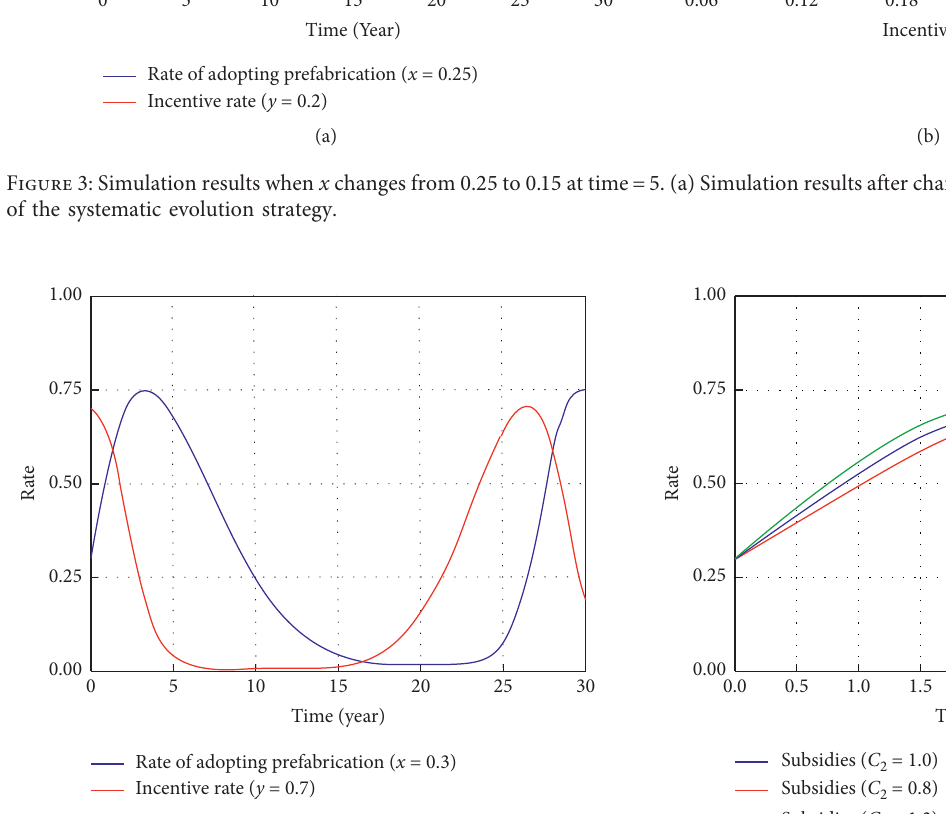
Figure 4: Simulation results under the baseline scenario.